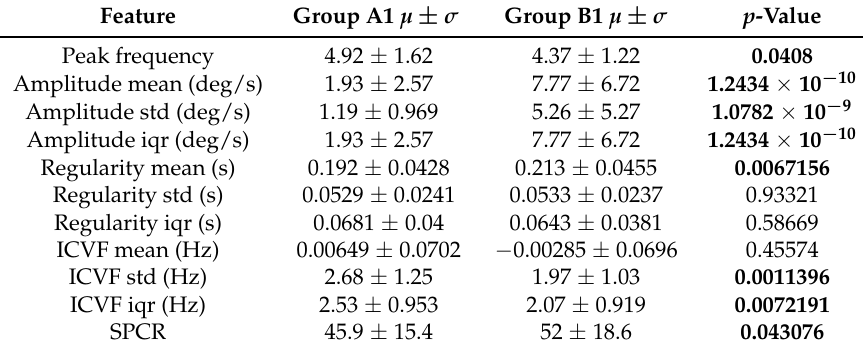
Table 3. Mean and standard deviation of different features for patients in A1 and B1 groups (ICVF—Inter-cycle variation of frequency; SPCR—Signal power concentration ratio; mean—average value; std—standard deviation; iqr—interquartile range). Statistically significant p -values ( p < 0.05) are highlighted with bold